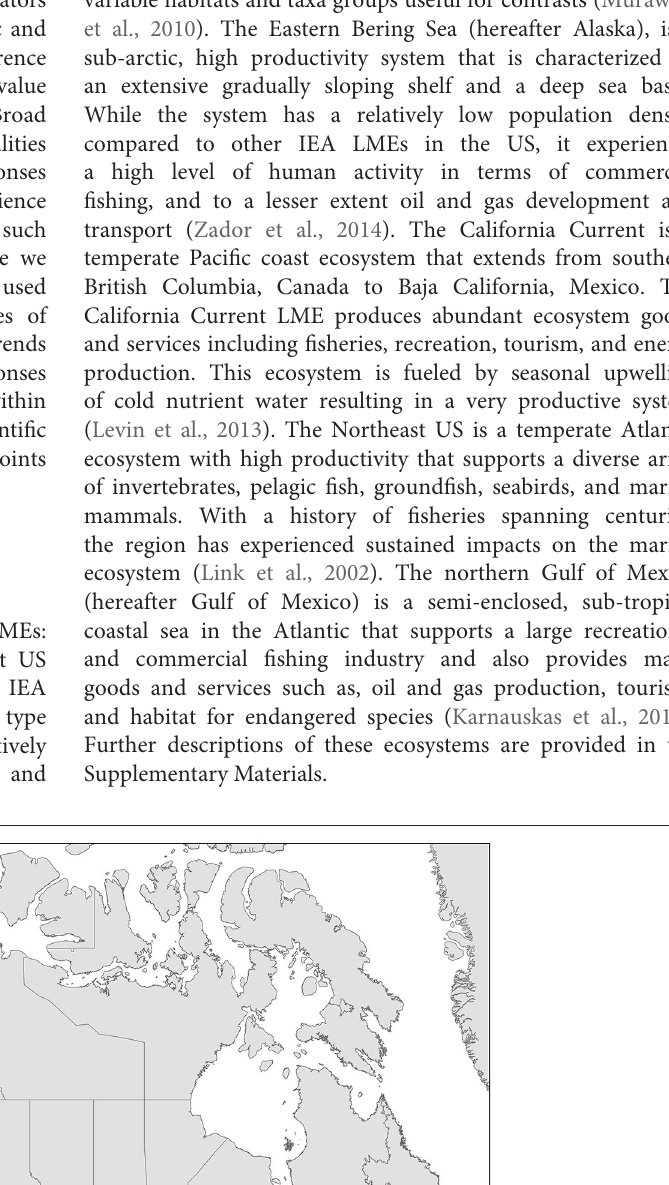
Frontiers in Marine Science |